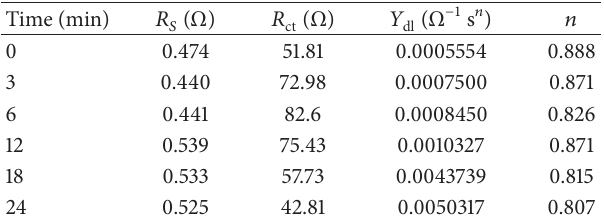
Table 4: Equivalent circuit parameters for effect of the addition of to base CO 2